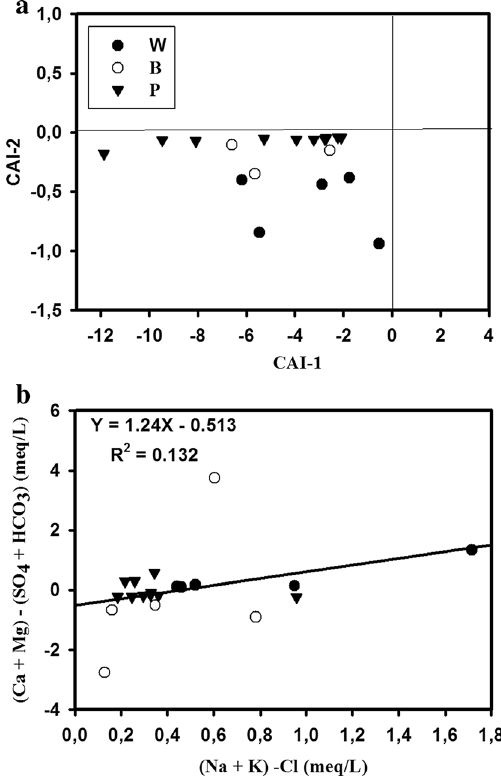
Fig. 6 a CAI-1 versus CAI-2 bivariate diagram and b weak linear relationship between Na + K–Cl and (Ca + Mg)–(SO 4 + HCO 3 ) and the groundwater